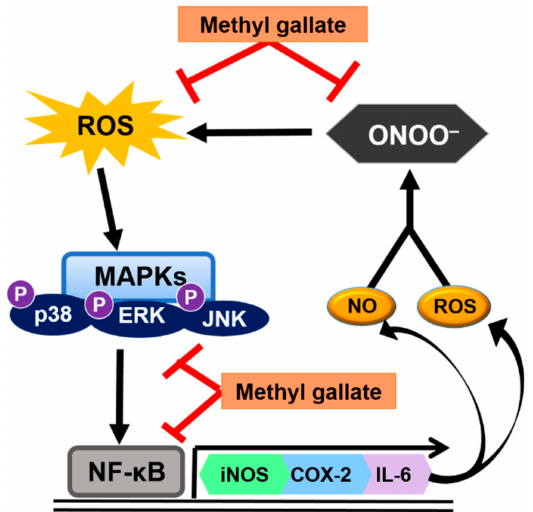
Figure 7. Predicted activity of methyl gallate in renal